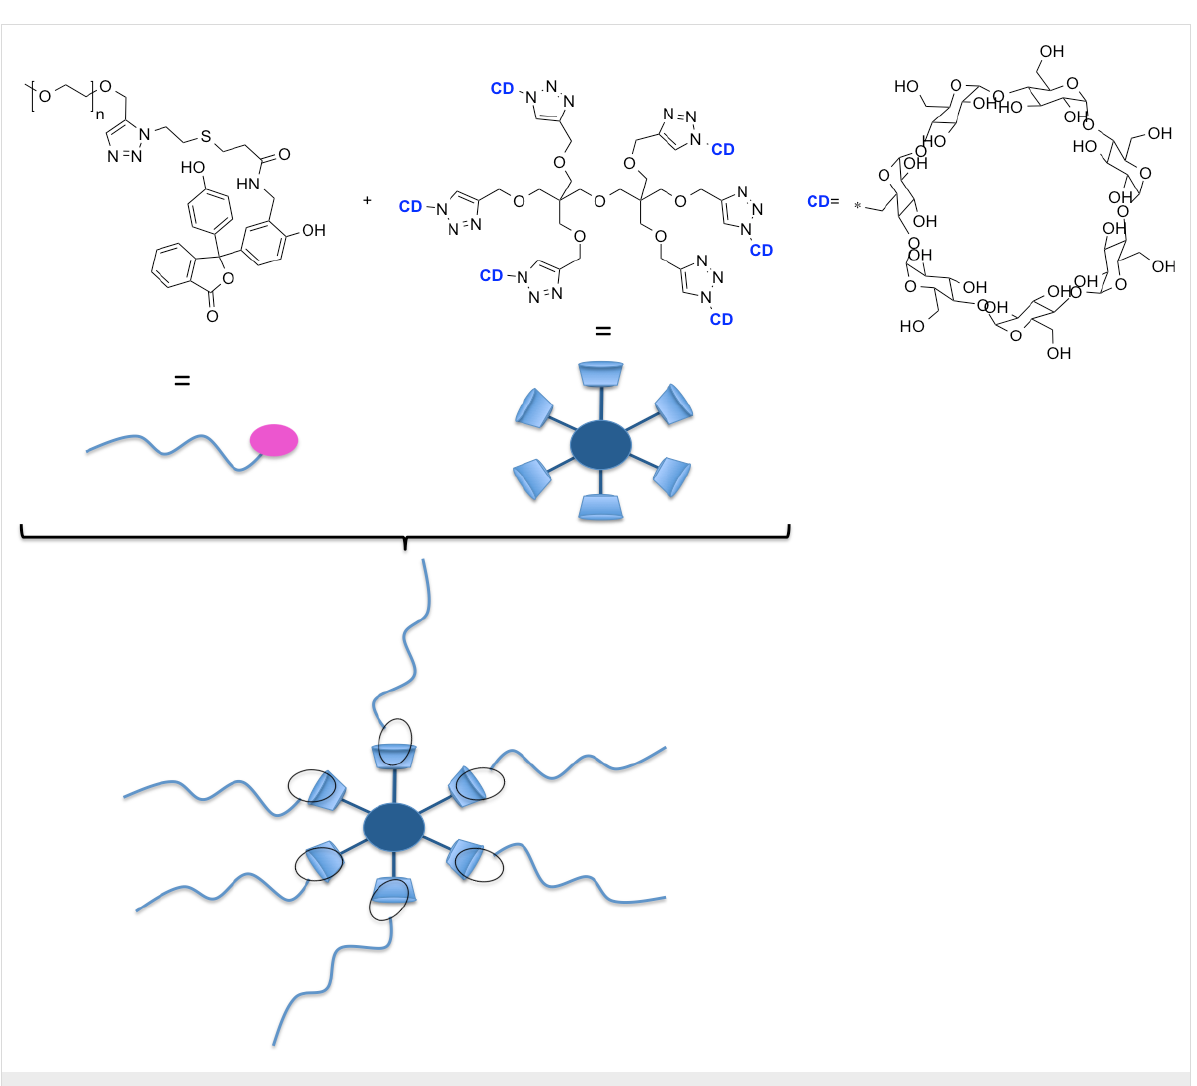
Figure 1: Schematic illustration of the complex formation of PEG-PP and DPE-CD